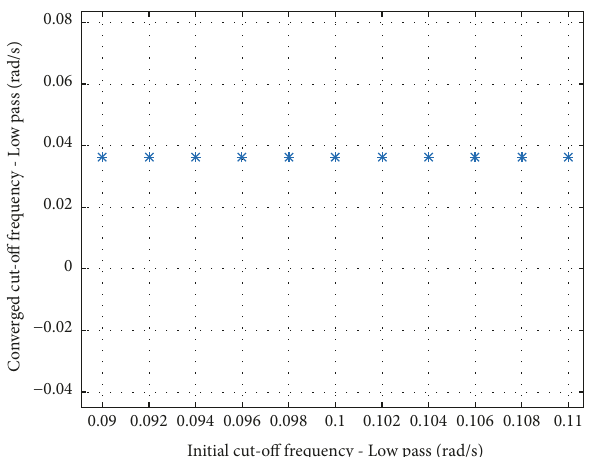
Figure 10: Initial cut-off frequency of the iterative algorithm versus the converged cut-off frequency: low-pass filter.